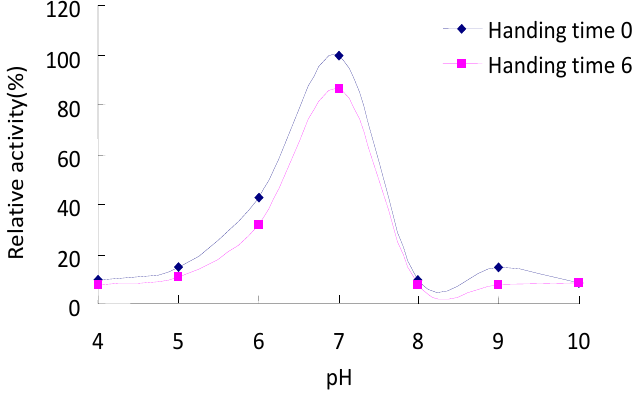
Figure 5. pH stability of the κ-carrageenase from Cellulophaga lytica strain N5-2. The different pH buffer was: Na HPO -Citric acid buffer (pH 4.0–7.0), Tris-HCl buffer 2 4 (pH 8.0 and 9.0) and glycine-NaOH buffer (pH 10.0). Pre-incubating the enzyme solution at each pH (4.0–10.0) at 35 °C for 6 h and then the enzyme activity was determined in the same pH buffer. The activity of untreated enzyme was regarded as 100% and relative activity was